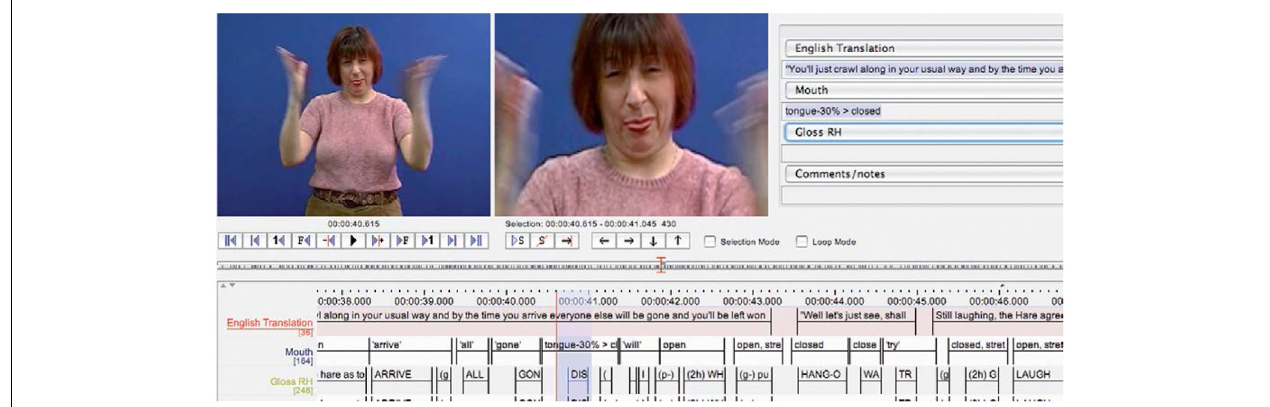
FIGURE 2 | BSL sign disappear showing initial configuration of mouth.